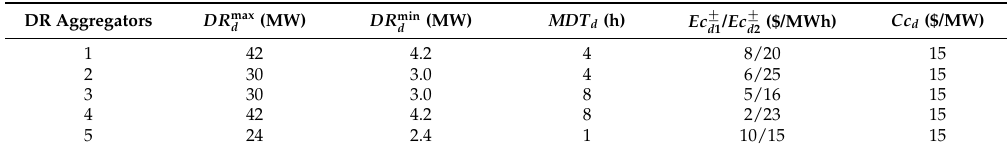
Table 10. DR aggregator characteristics in IEEE 118 case.